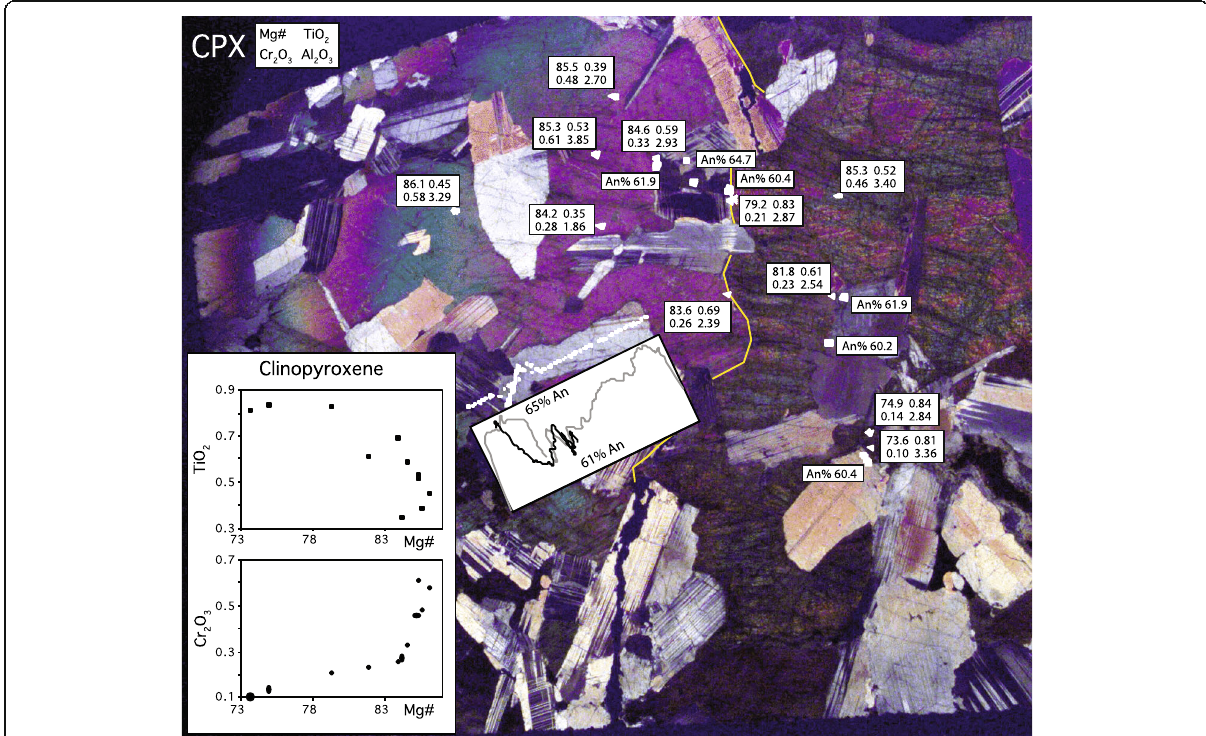
Fig. 13 Thin section microphotograph 4 cm across under cross polars. Augite oikocrysts in olivine gabbro JR31-12-6, with a curved irregular contact shown by the yellow line. The augite encloses partially resorbed plagioclase chadocrysts but no olivine, which is found elsewhere in the sample. Analytical spots are shown by white points. White boxes next to points give the Mg#, weight percent TiO 2 , Cr 2 O 3 , and Al 2 O 3 in the pyroxene analyses as indicated by the small inset box in the upper left corner. Large inset shows the Cpx data in TiO 2 and Cr 2 O 3 versus Mg# binary plots. Also shown is an inset plot of core to rim plagioclase compositions oriented parallel to the actual line of analytical points for one elongate chadocryst (gray line) and for a shorter crossing traverse (black line). Field of view is 4 mm across. With the exception of the long, reversely zoned traverse